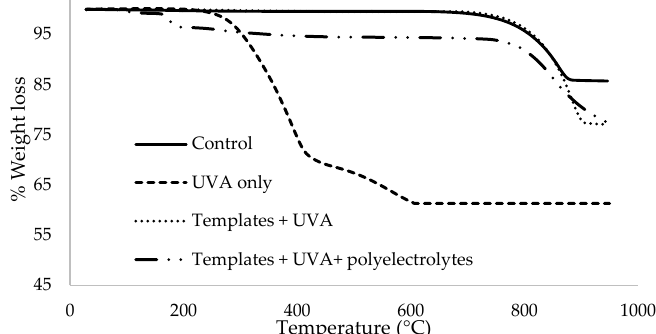
Figure 9. Thermoanalysis curves of samples of control, UVAs only, CaCO 3 templates + UVAs, and on CaCO 3 templates with UVAs and polyelectrolytes.